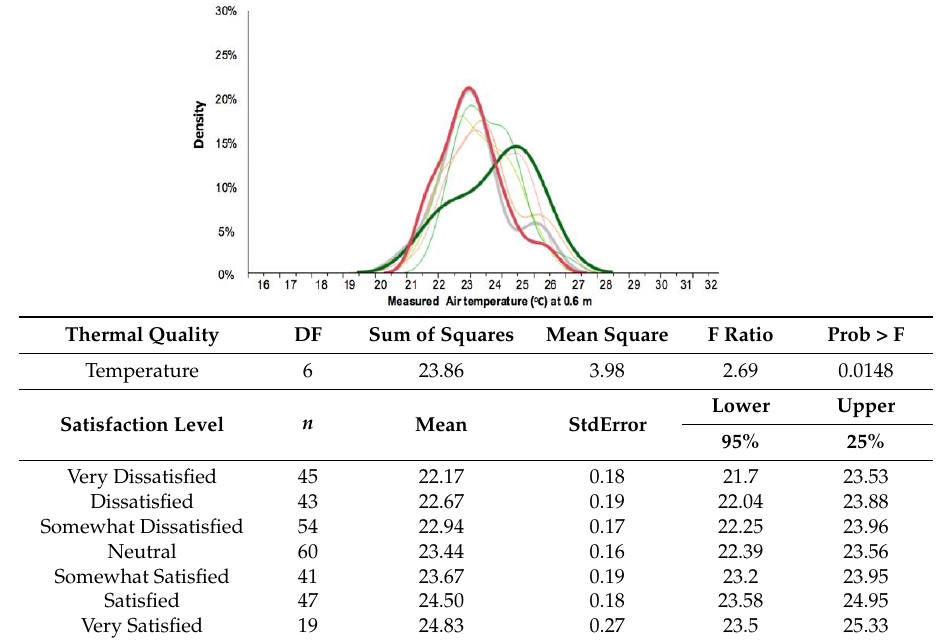
Table 7. Analysis of variance of air temperature at 60 cm from the floor by user satisfaction, cooling season ( n = 309).